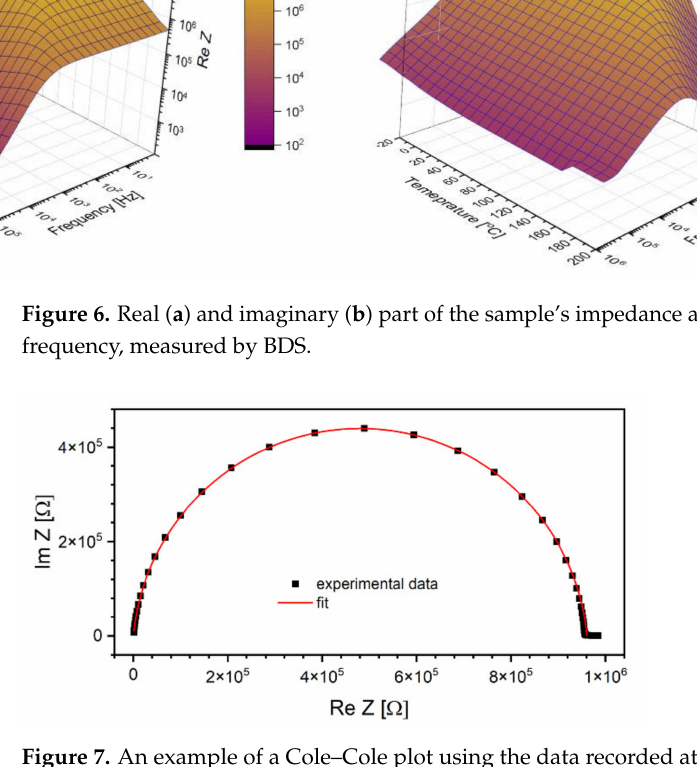
Figure 7. An example of a Cole–Cole plot using the data recorded at T = 180 ◦ C. Right-hand side of the semicircle corresponds to lower frequencies, while the left-hand side to high frequencies